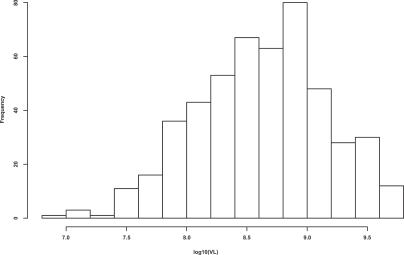
Histogram of Viral Loads, Generated from Variable Activation Parameter (α)